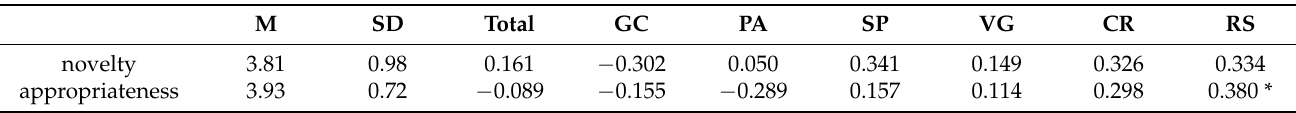
Table 2. Correlation between the quantity of utterances of emergent leader and the indicators of group